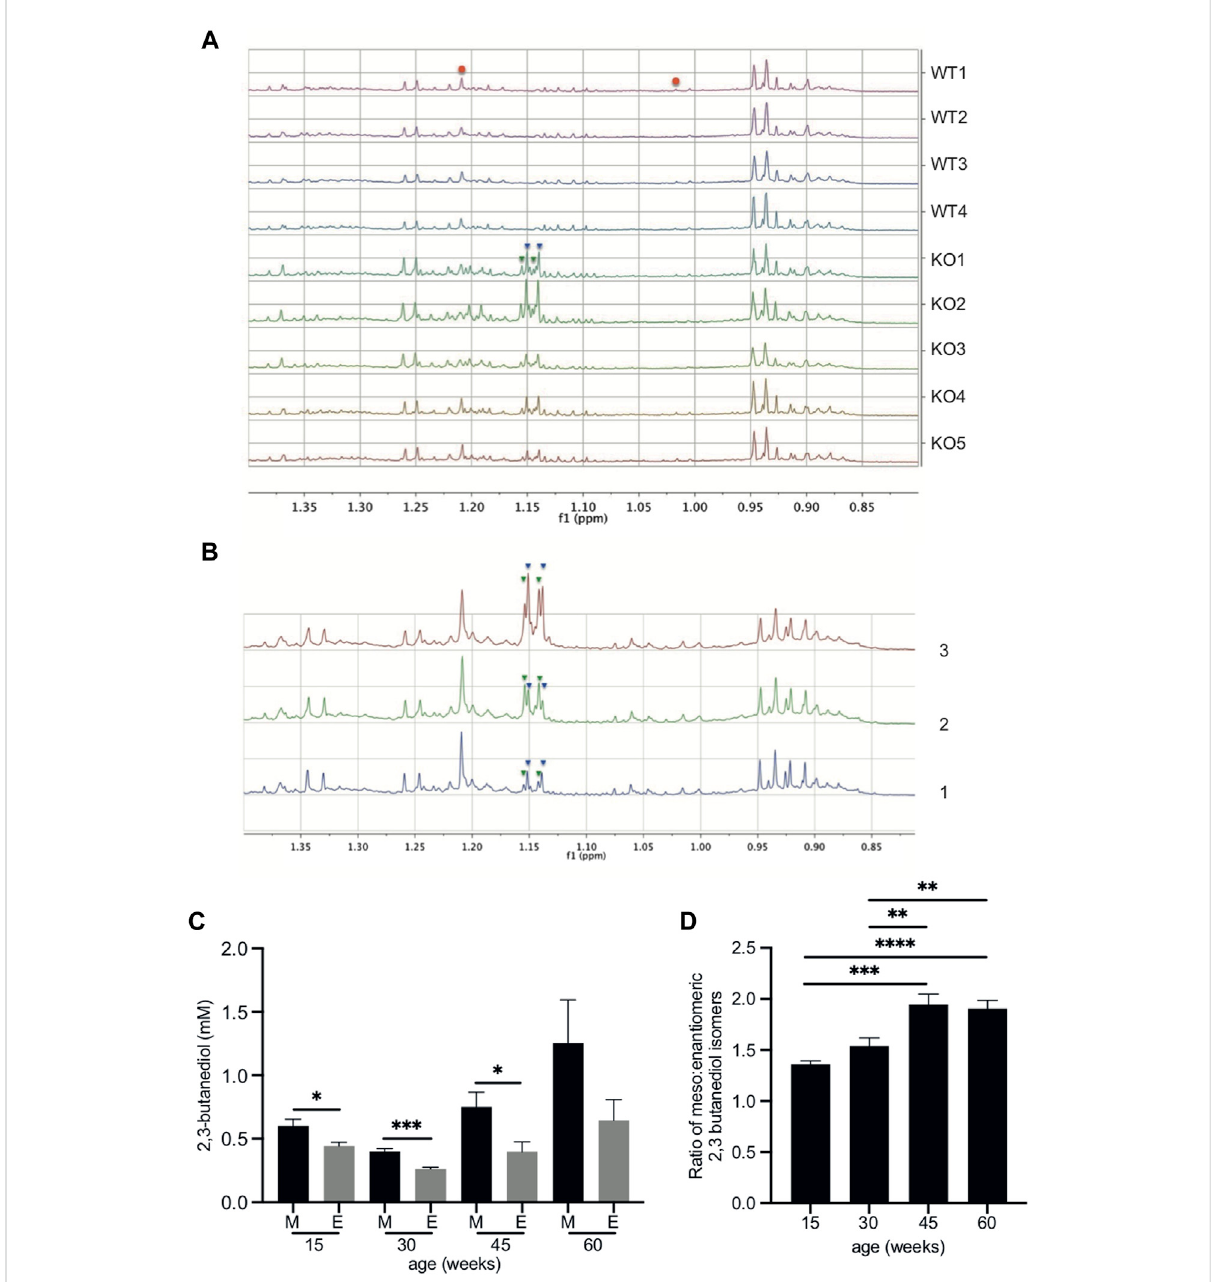
FIGURE 1 2,3-butanediol is present in the urine of Fmo5 − / − but not wild-type mice. (A) The low-frequency region of the 600 MHz 1 H NMR spectra from 60-week-old male Fmo5 − / − (KO) and wild-type (WT) mice. The pseudo-doublet signals at ca. 1.146 (inverted blue triangles) and 1.149 ppm (inverted green triangles) are present only in the spectra of the urine of Fmo5 − / − mice. Note that the singlet at ca. 1.208 ppm and the broad triplet at ca. 1.015 ppm are due to methyl signals from 6-hydroxy-6-methyl-heptan-3-one (red circles), and are at a lower intensity in older mice, as this male sex pheromone has been shown to decrease with age (Varshavi et al., 2018). (B) Con fi rmation of 2,3-butanediol identity in Fmo5 − / − mouse urine. (1) The low-frequency region of the 600 MHz 1 H NMR spectrum of urine from a 30-week-old male Fmo5 − / − mouse. (2) The NMR spectrum of thesameurinesamplererunaftertheadditionofasmallquantityofauthentic2R,3R-butanediol(invertedgreentriangles)intotheurine.(3)TheNMR spectrum after asubsequent addition ofauthenticmeso-2,3-butanediol (inverted bluetriangles)into theurine. (C) Concentrationsof2,3 butanediol isomers in Fmo5 − / − male mouse urine. Meso (M) and enantiomeric (E) forms were quanti fi ed in urine from mice aged 15 ( n = 4 KO, n = 4 WT), 30 ( n = 4KO, n =4WT; set1: n =5KO, n = 5WT;set2),45( n =5KO, n = 4WT)and 60( n = 5KO, n =4WT)weeks. (D) Ratio ofmeso: enantiomericformsof 2,3-butanediol in Fmo5 − / − male mouse urine at different ages. Data in parts (C,D) are expressed as means ± SEM. * p < 0.05, ** p < 0.01, *** p < 0.001, **** p <